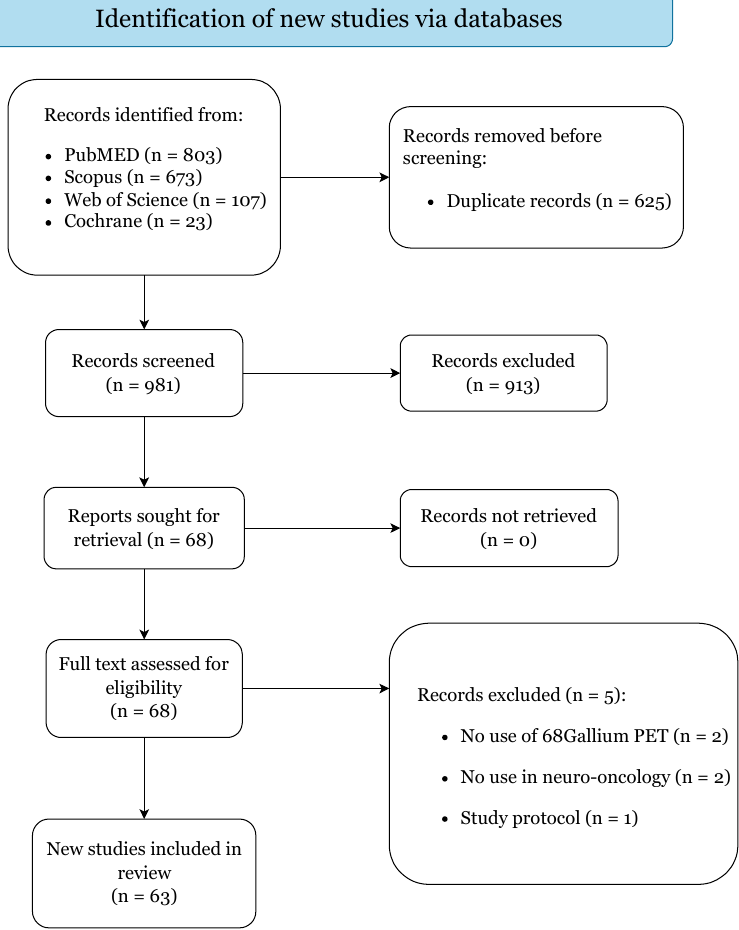
Figure 1. PRISMA 2020 flow diagram.